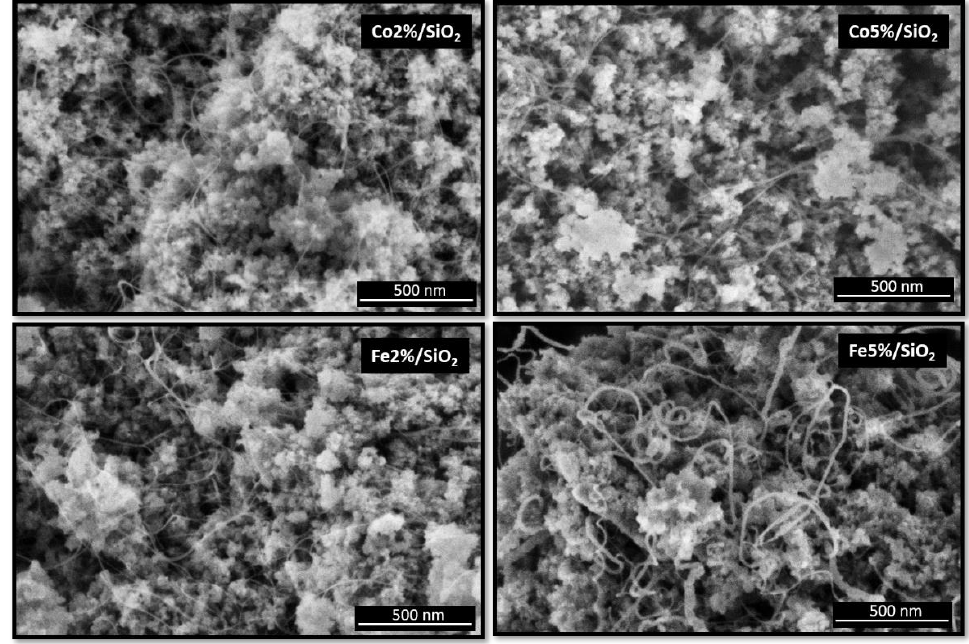
Figure 5. SEM micrographs from Co and Fe catalyst (2 and 5%) on SiO 2 surface after CNT growth. The CNTs grown over cobalt catalysts present similar morphology. An average diameter size of around 8 nm was measured for samples containing 2 and 5% of Co. This behaviour was not observed on substrates covered by Fe catalysts. An increase in CNT diameter from 8 to 13 nm was observed when Fe content increases from 2 to 5%. Fe5%/SiO 2 samples also presented a broader size CNT size distribution (FWHM ~10 nm) in comparison to the other three samples (FWHM ~5 nm) (Figure 6). The CNT length was estimated to be longer than 500 nm regarding the scale bar from the SEM micrographs.